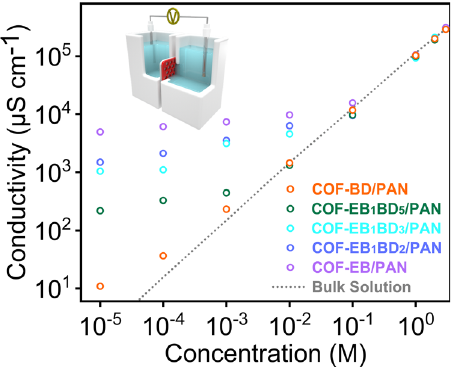
Fig. 2 Surface-charge-governed ion transport. Plots of COF-EB x BD y /PAN conductivity against KCl concentration (dashed line: ion conductivity of the bulk solution; inset: schematic of the experimental setup for measuring the transmembrane ion